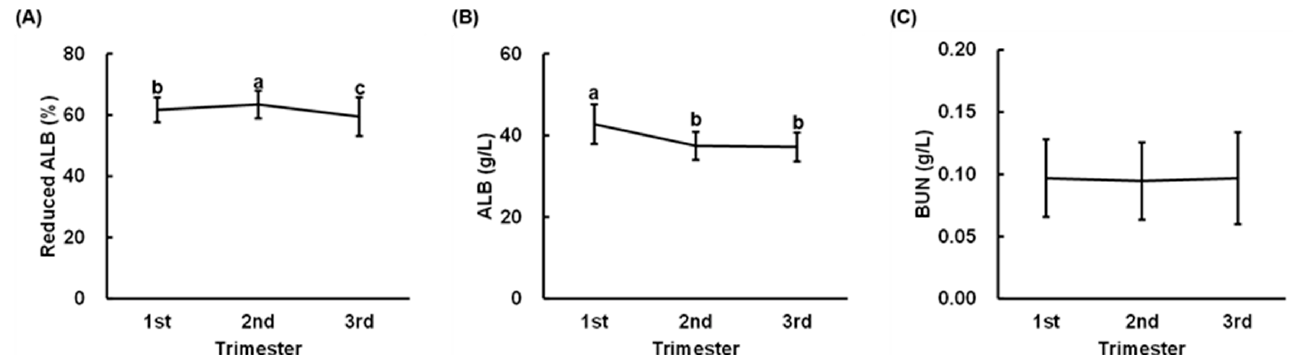
Figure 2. Serum reduced albumin (ALB) ratio, ALB concentration, and blood urea nitrogen (BUN) concentration in pregnant women. Serum samples of pregnant women, obtained in the first-third trimester, were applied to the analyses of reduced